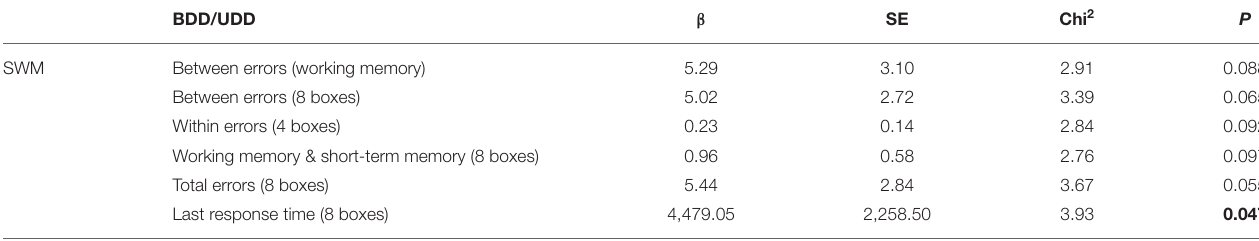
TABLE 1 | Results of GEE analysis regarding the effects of depression types on CANTAB scores. BDD/UDD β SE Chi 2 P SWM Between errors (working memory) Between errors (8 boxes)